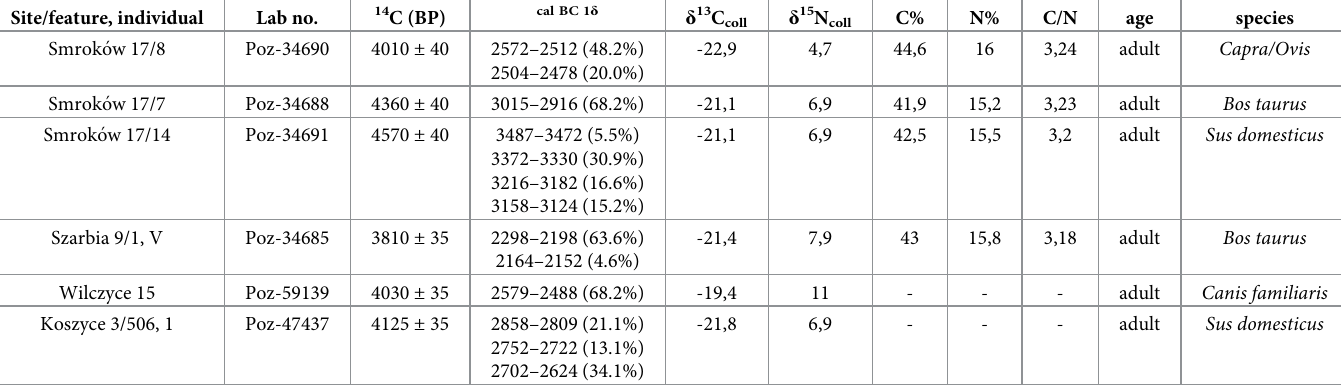
Table 2. Results of radiocarbon dating and stable isotope analyses of animal bones. Site/feature, individual